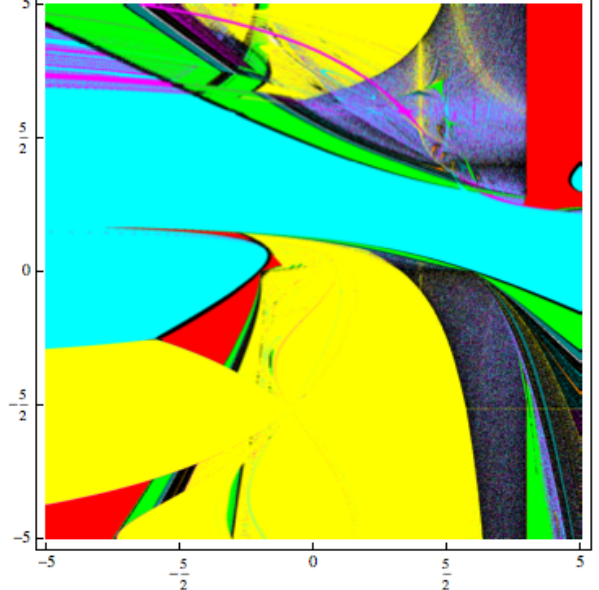
Figure 1. Convergence plane of method (2). The starting point is z 0 = 0.5.